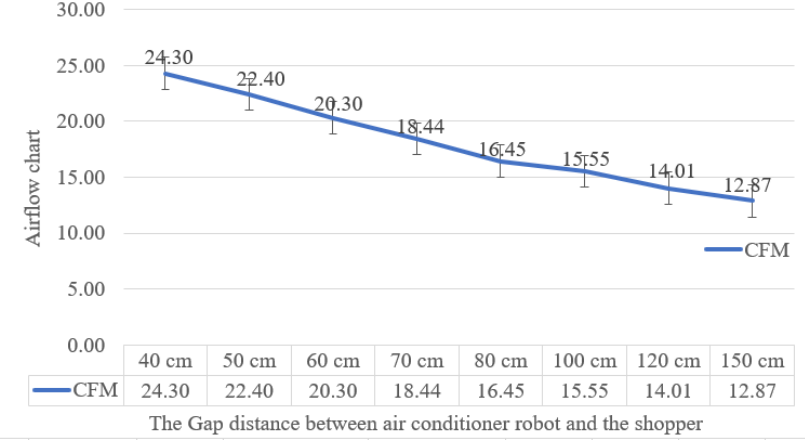
Figure 21. Schematic of experiment and airflow display simulation.